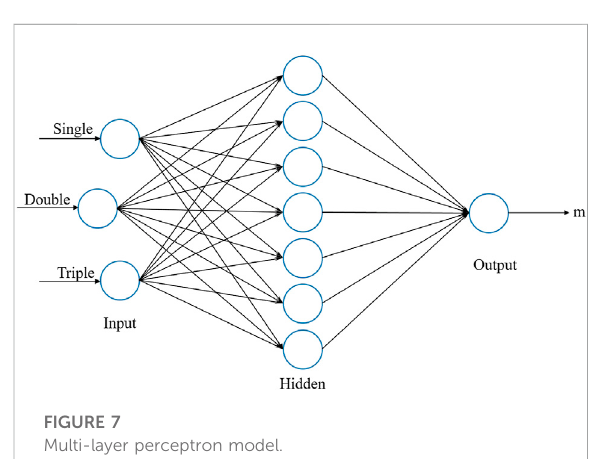
FIGURE 7 Multi-layer perceptron